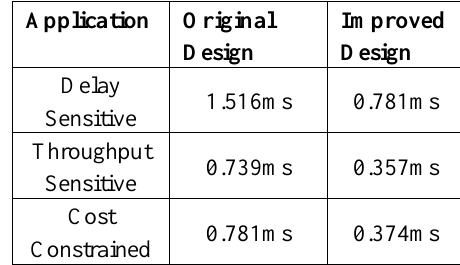
Table 2. Average calculation time for Cellular network.